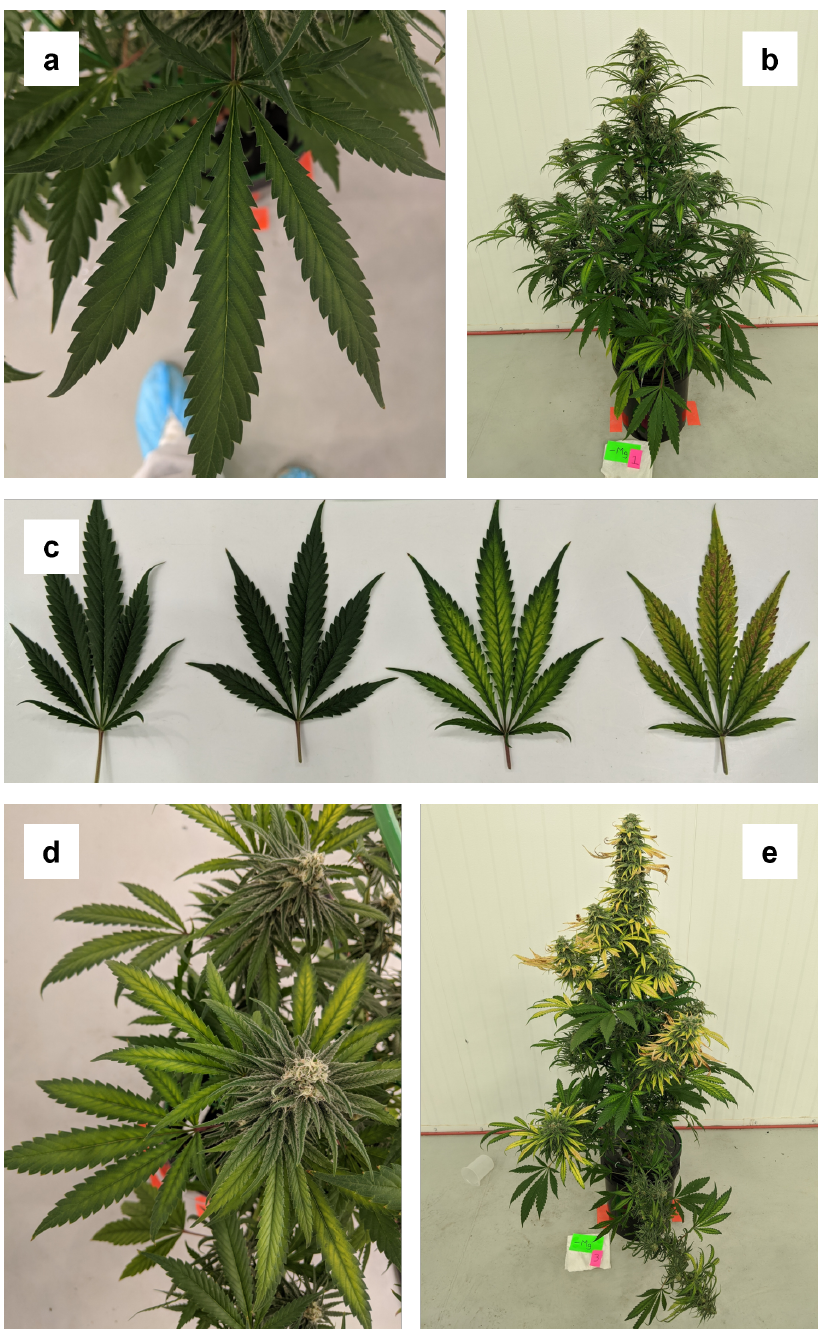
Figure 6. Progression of magnesium deficiency, first appearing in week four ( a ), with interveinal chlorotic ( b ) moving towards necrotic areas in between the leaflet midrib and margins ( c ). In week five, most of the smaller fan leaves started to show symptoms ( d ), and by week six, magnesium deficiency was widespread across the entire plant, except for some of the older and larger fan leaves ( e